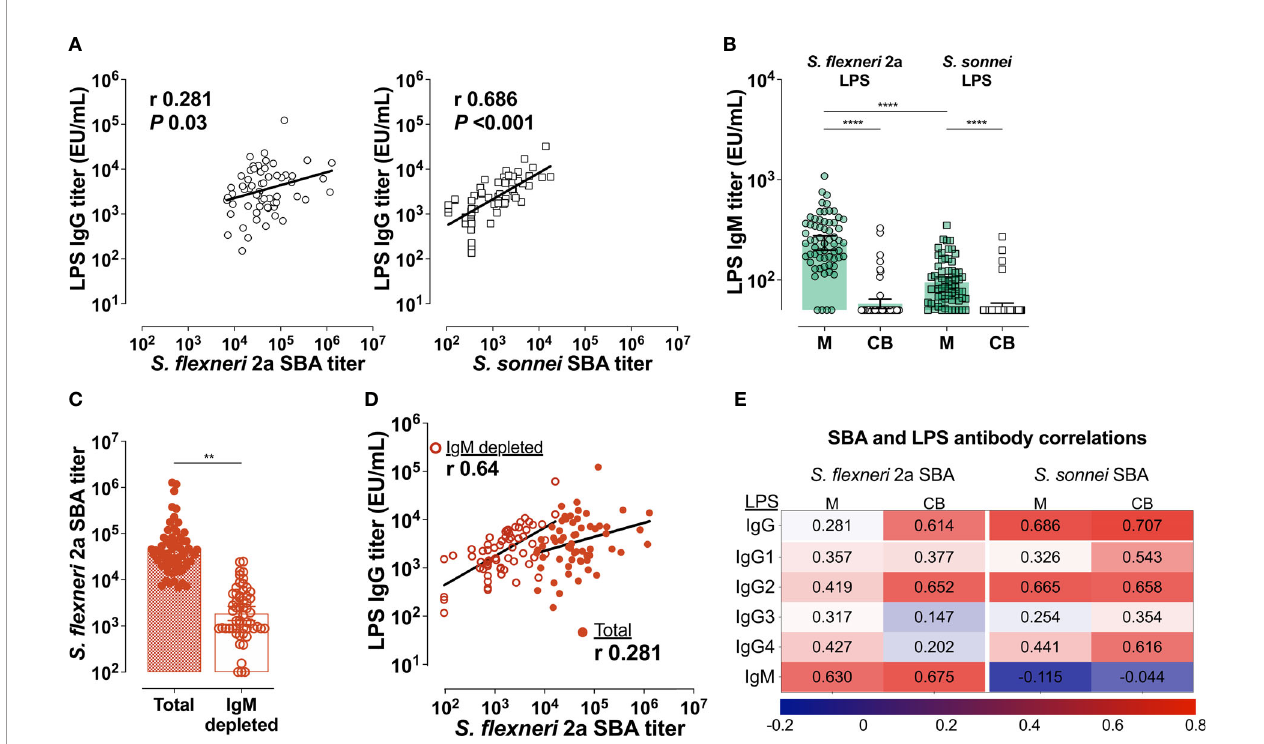
FIGURE 6 | Shigella LPS-speci fi c IgG and IgM mediate bactericidal activity. (A) Correlations between maternal LPS IgG and SBA for S. fl exneri 2a (left panel) or S. sonnei (right panel). (B) Mean IgM titers (bars) against S. fl exneri 2a and S. sonnei LPS in maternal (M) and cord blood (CB) Symbols represent individual titers. Maternal and cord blood titers were compared by one-way ANOVA with a Tukey ’ s post-test correction; **** P < 0.0001. (C) Mean SBA titers (bars) in maternal serum before (Total) or after IgM depletion (IgM depleted). SBA titers in the two groups were compared by paired t-test; ** P < 0.01. Symbols represent individual titers. (D) Associations between S. fl exneri 2a LPS IgG and SBA titers before ( fi lled circle) and after IgM depletion (open circles). Pearson ’ s r values are shown within the graph. (E) Heatmap showing associations (Pearson ’ s r) between SBA and Total IgG, IgG subclasses and IgM against